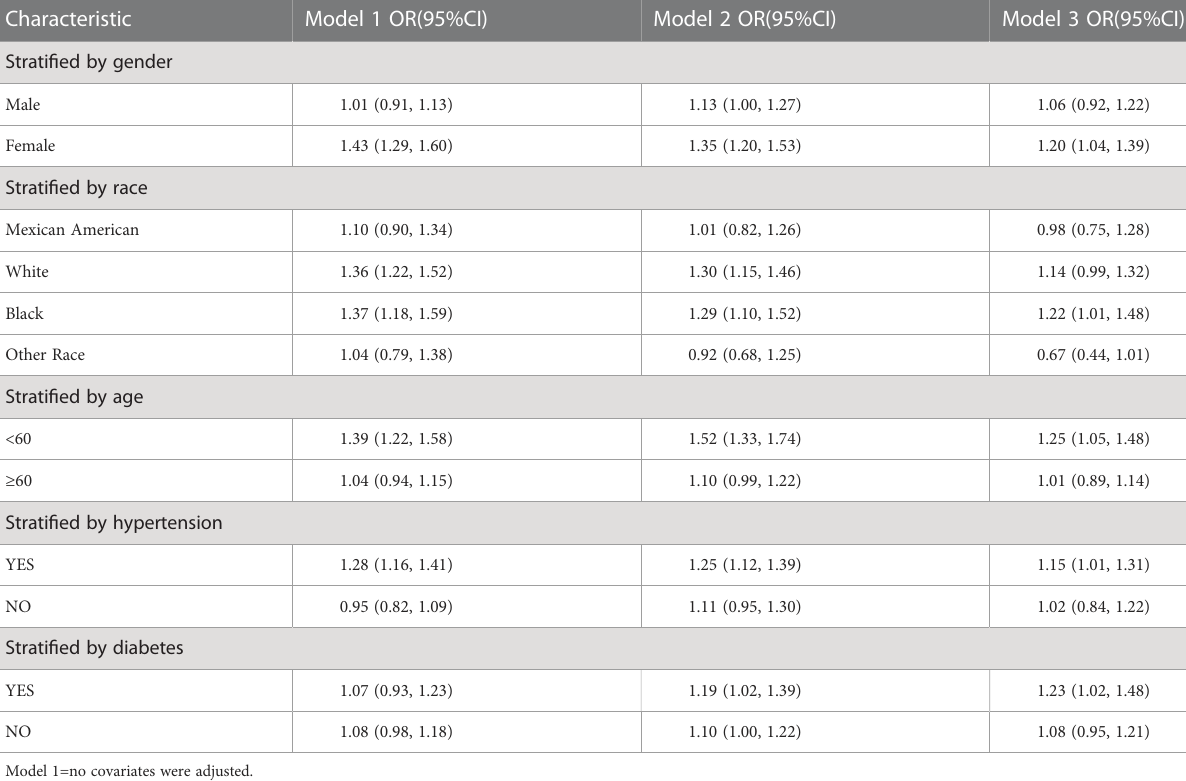
TABLE 3 Subgroup analysis between VAI with stroke prevalence.